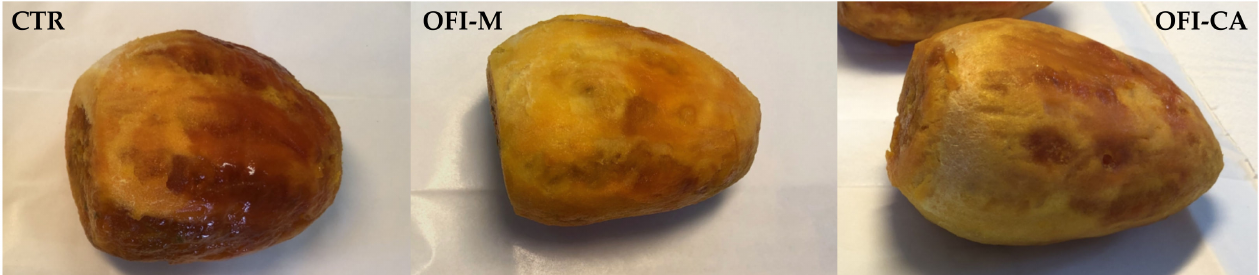
Figure 6. Minimally O. ficus-indica fruits non-treated (OFI-CTR) and treated with mucilage (OFI-M) and calcium ascorbate coating (OFI-CA) at the end of the cold storage (9 days at 5 ◦